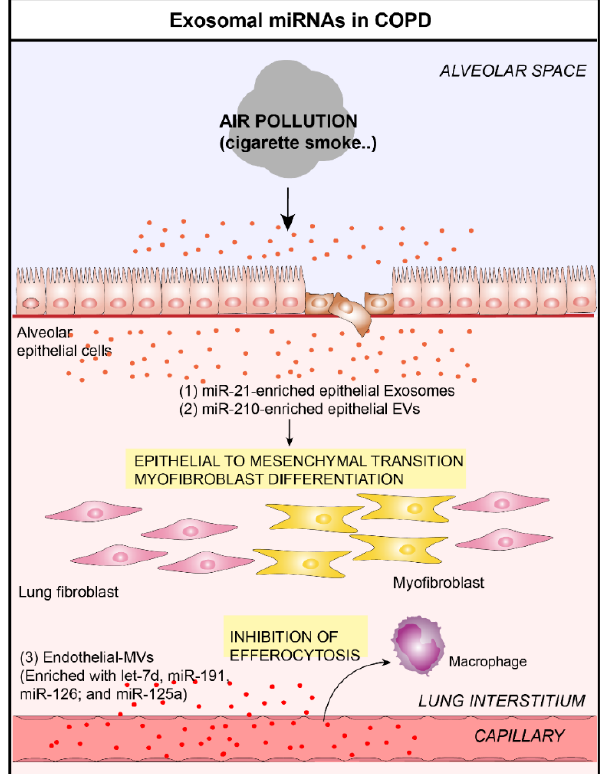
Figure 2. Role of lung EVs in the pathogenesis of Chronic Obstructive Pulmonary Disease (COPD). In the context of COPD, bronchial ECs-derived EVs are able to induce myofibroblast differentiation by the delivery of ( 1 ) miR-21 [30] and ( 2 ) miR-210 [31] to lung fibroblasts. ( 3 ) Furthermore, endothelial-derived EVs are able to inhibit the clearance of apoptotic cells by delivering let-7d, miR-191, miR-126, and miR-125a in lung macrophages [17].